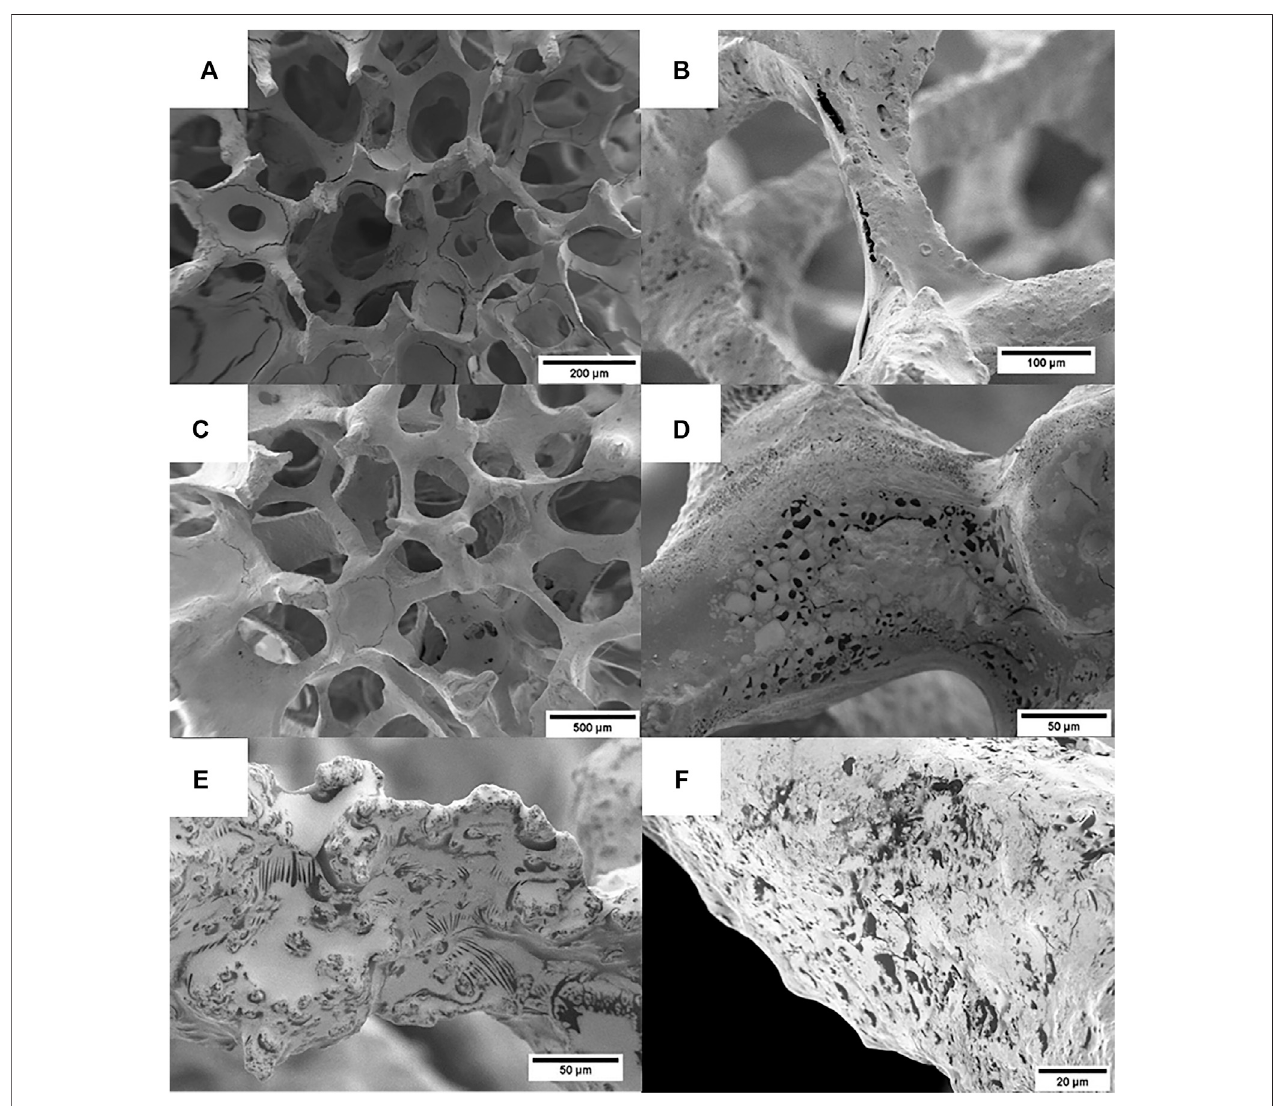
FIGURE2| SEMimagesofcoatedscaffolds: (A,B) zeincoatedscaffolds, (C – E) zein+10wt.%MHscaffolds, (F) zein+20wt.%MHscaffolds.MHcanbeidenti fi ed in the coating as the black/dark areas.